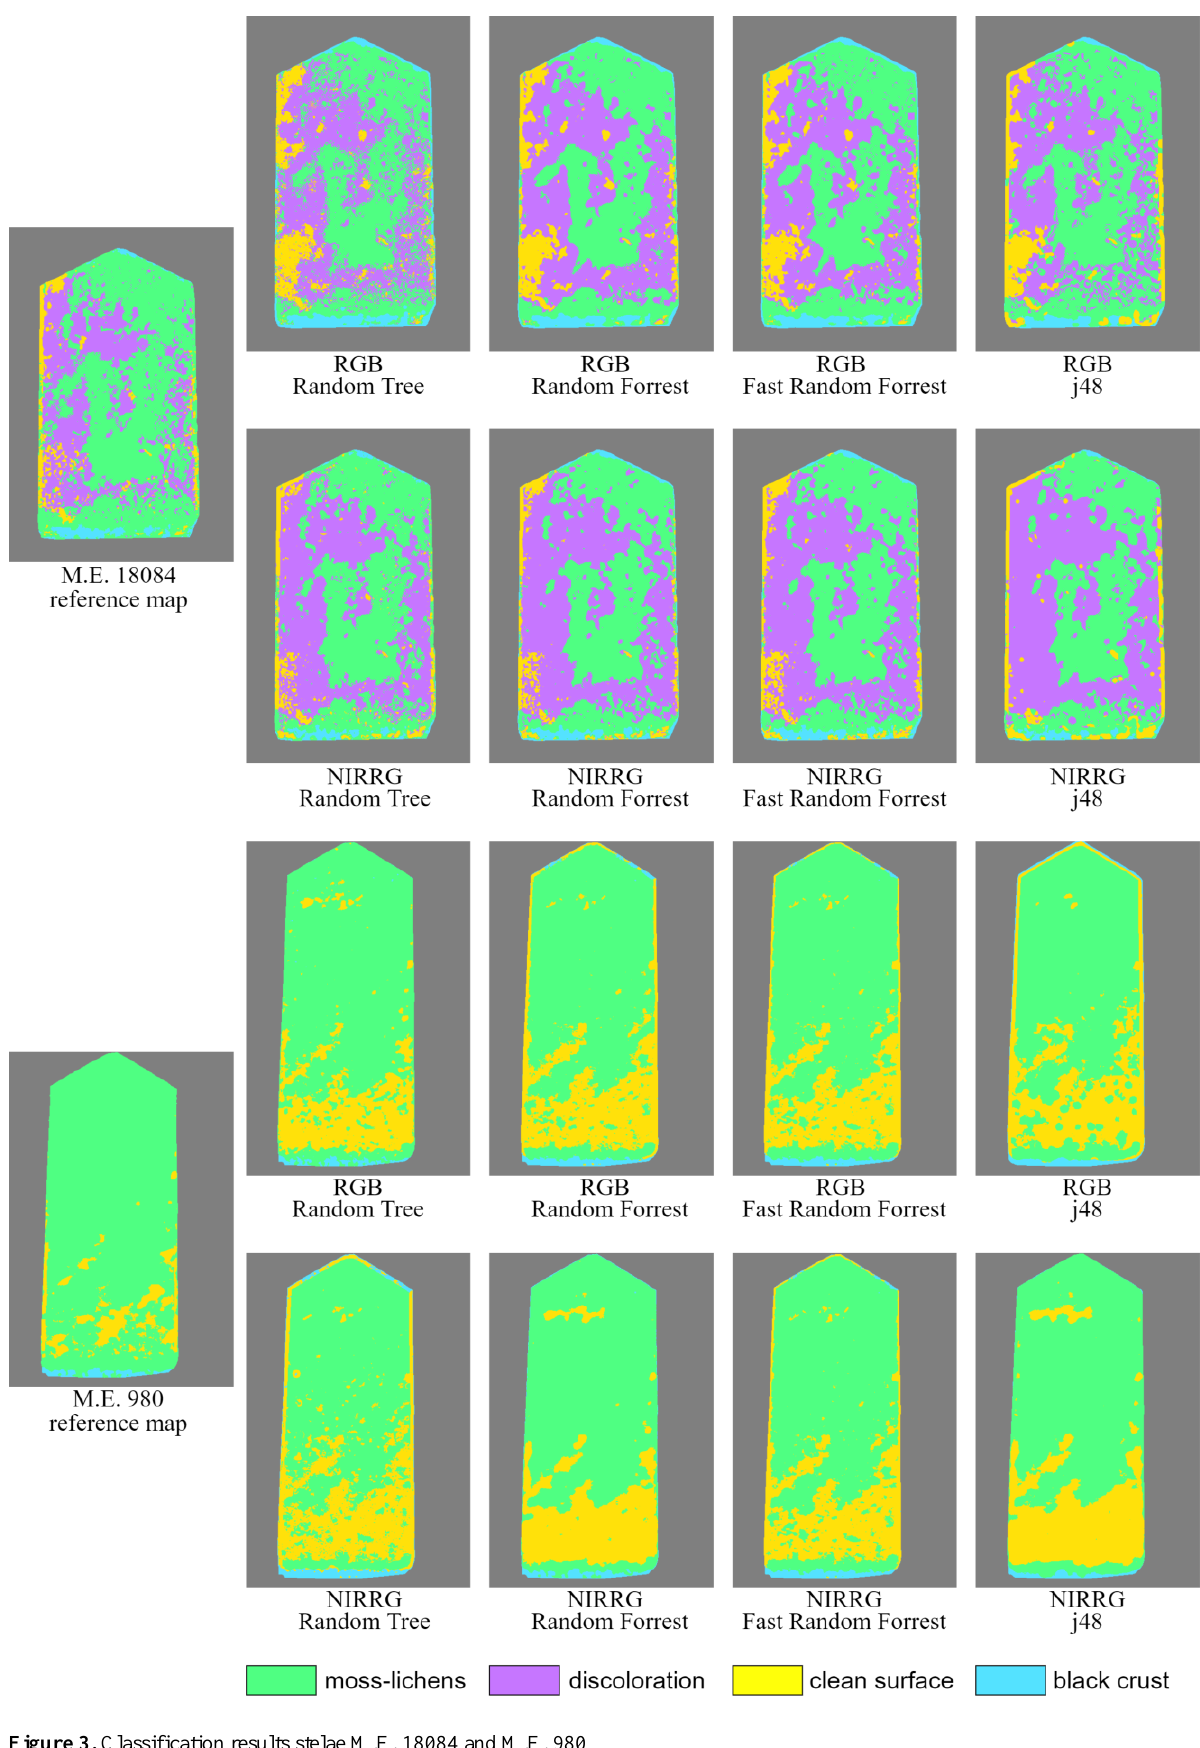
Figure 3. Classification results stelae M.E. 18084 and M.E.